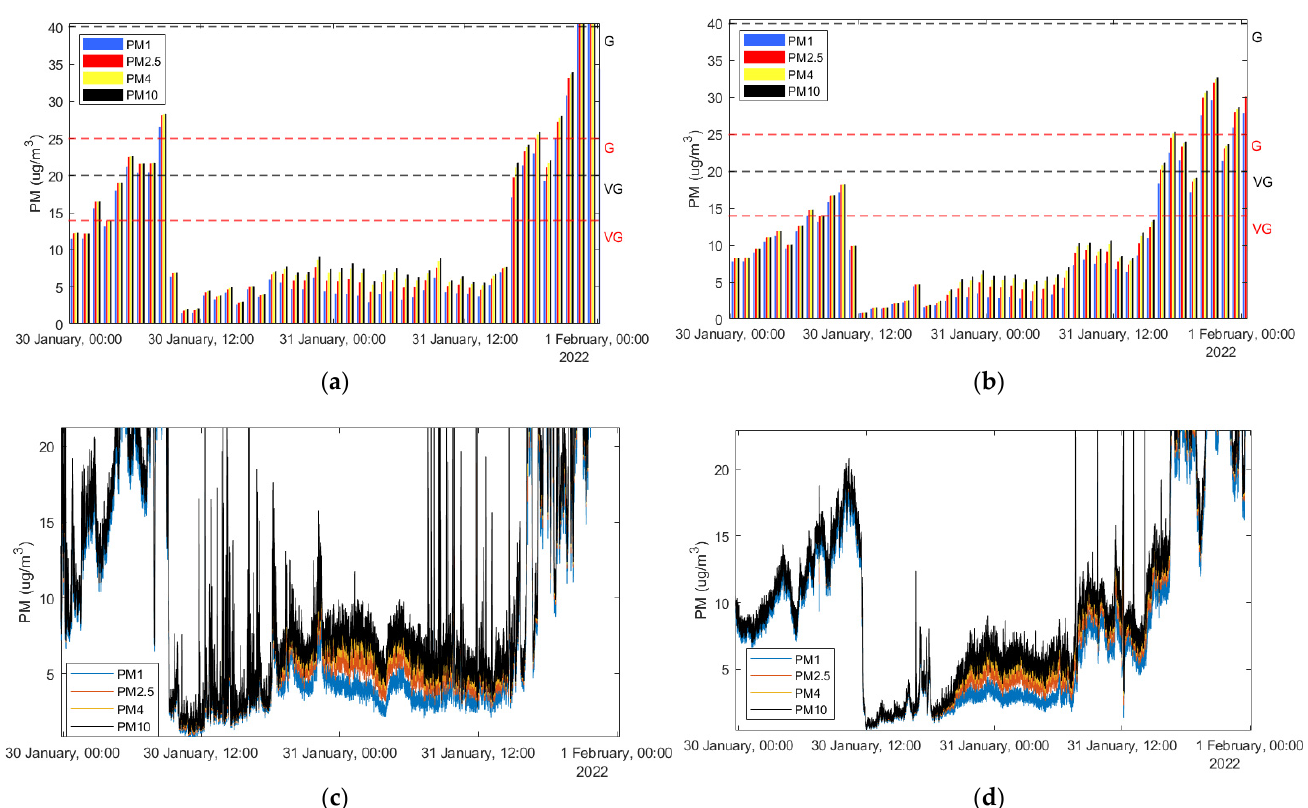
Figure 9. Changes in the mass concentration of PM over two days from 30 January 2022 (00:00 a.m.) to 31 January 2022 (11:59 p.m.)—bar graphs of hourly averages of PM1, PM2.5, PM4, and PM10 at ( a ) Habura and ( b ) DTIEE, where dashed lines correspond to the upper limits of very good (VG) or good (G) air quality for hourly mass concentrations of PM2.5 (red dashed line) and PM10 (black dashed line); measured values of PM1, PM2.5, PM4, and PM10 at ( c ) Habura and ( d ) DTIEE.